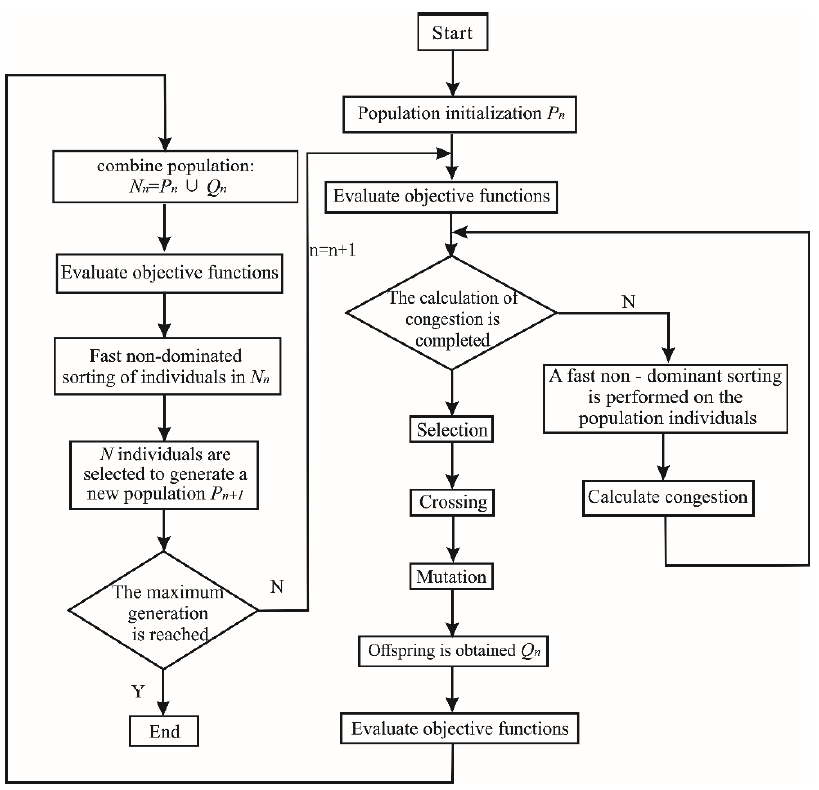
Figure 3. NSGA-II algorithm flow chart.